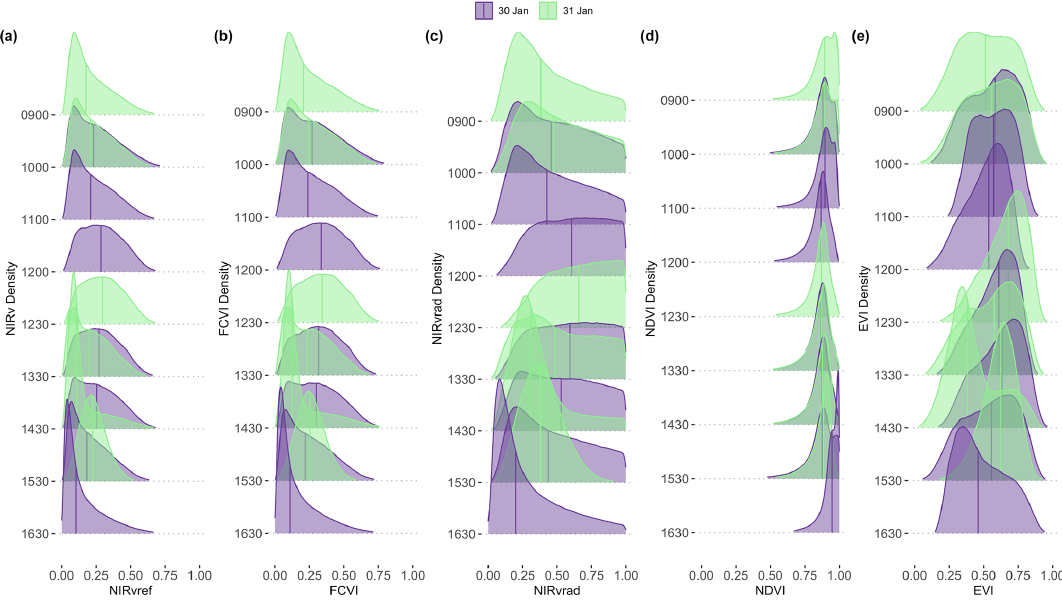
Figure 3. NIRv (a) , FCVI (b) , and NIRvrad (c) density plots for each flight time on 30 and 31 January 2019. Colors of distributions indicate